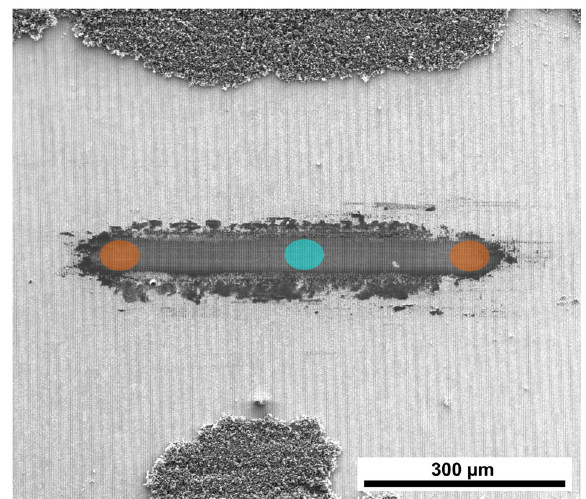
Fig. 8 Exemplary top view scanning electron micrograph of a CO- coated wear track (low depth laser pattern) post friction testing. This image marks the areas where the Raman measurements were